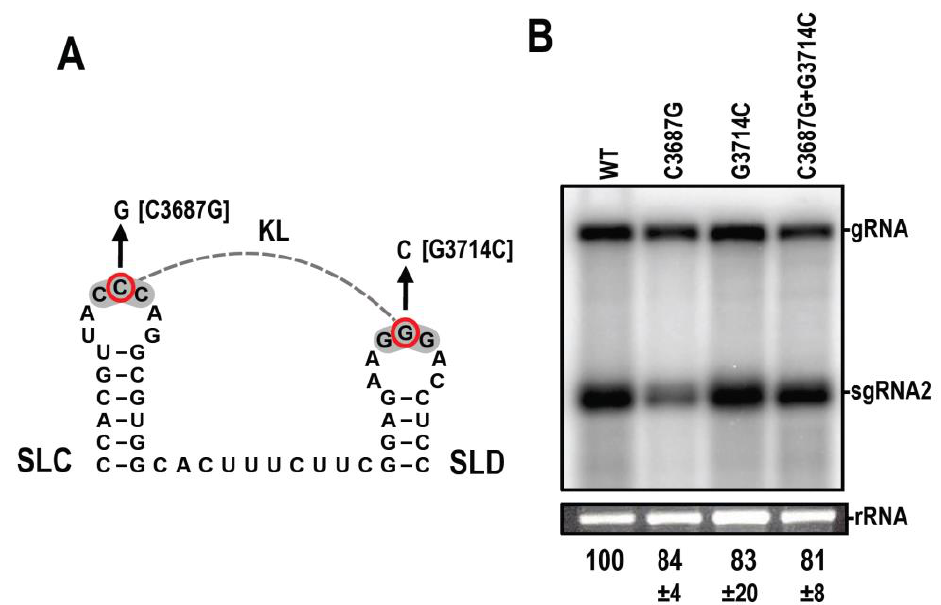
Figure 7. Disruption of the putative KL between SLX and SLY does not affect the accumulation of OPMV in infiltrated leaves. ( A ). C3687G and G3714C (indicated by red circles) were introduced to disrupt a KL. ( B ). RNA gel blot analysis of total RNA extracted from systemically infected N. benthamiana following agroinfiltration with either WT OPMV or OPMV containing either single or double mutations. Ethidium bromide-stained 26S rRNA was used as a loading control.